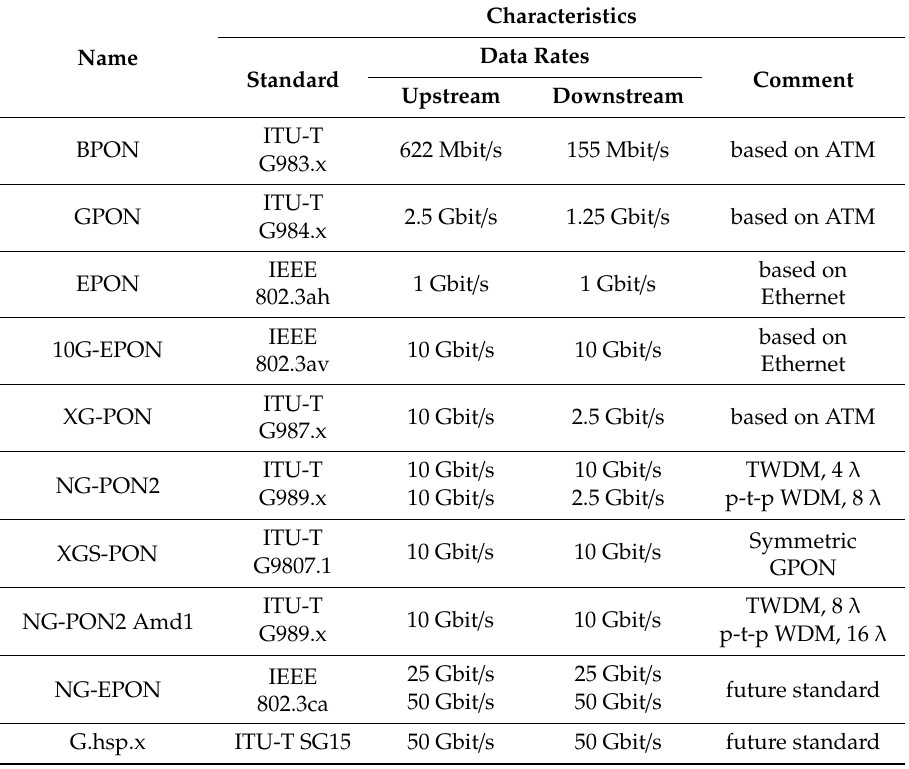
Table 4. Passive optical network (PON)